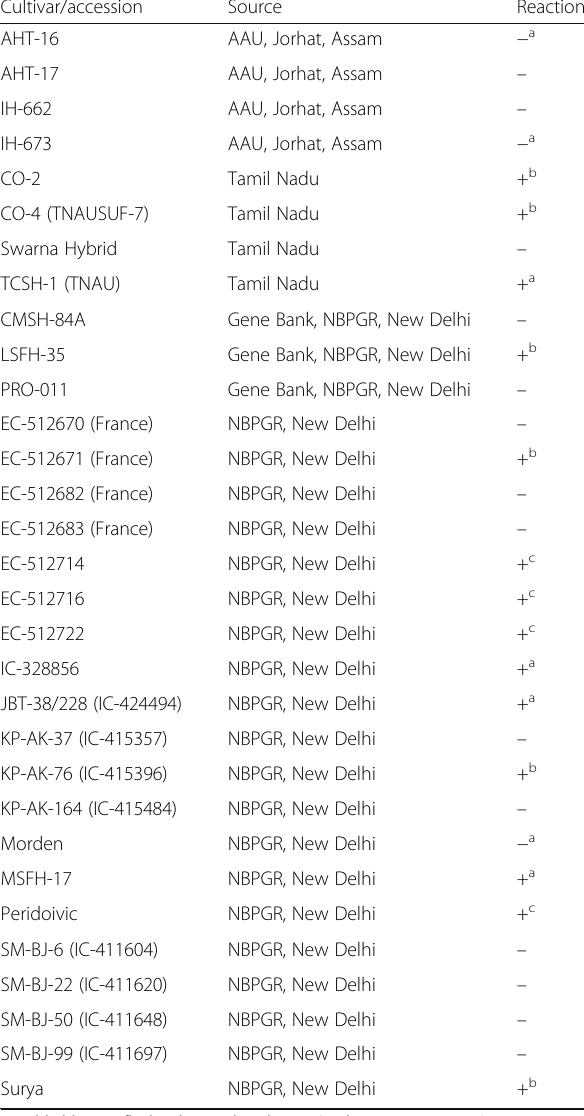
Table 3 Reaction of sunflower ( Helianthus annuus ) cultivars/ accessions to Puccinia spegazzinii (Peruvian pathotype)